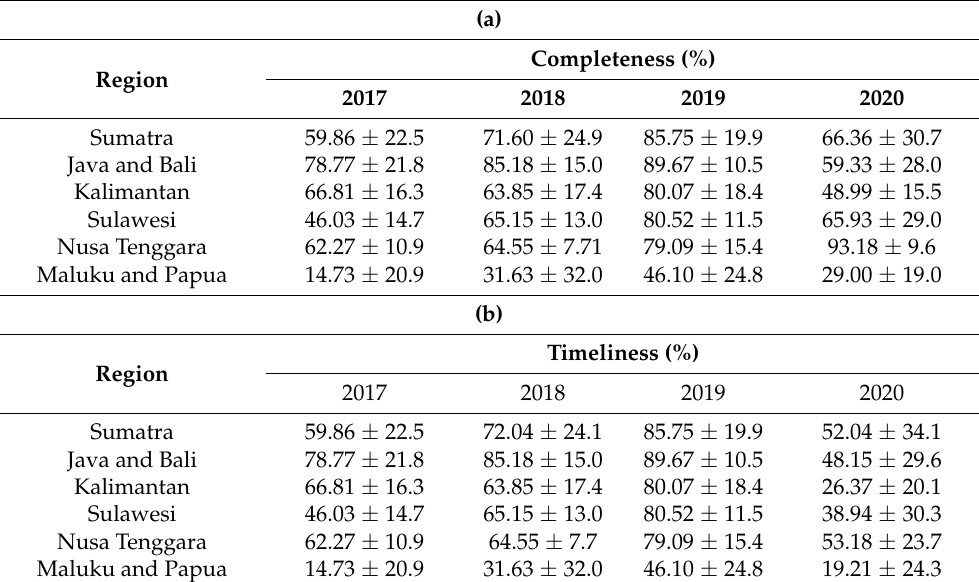
Table 1. ( a ) Percentage of completeness reports between 2017–2020 in Indonesia. ( b ) Percentage of timeliness reports between 2017–2020 in Indonesia.